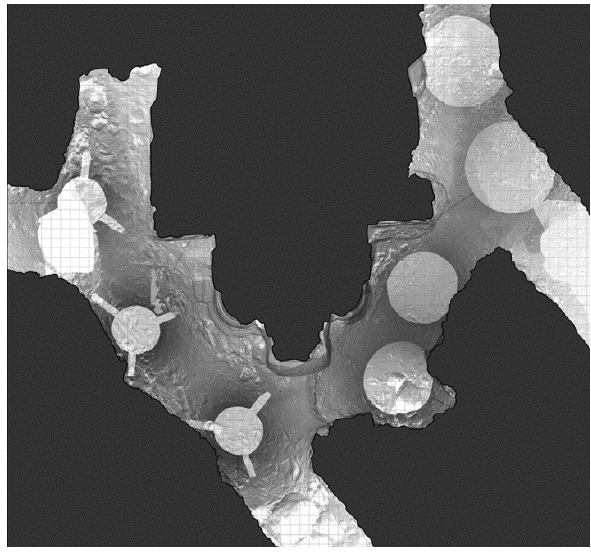
Figure 3. 2D orthographic view: horizontal